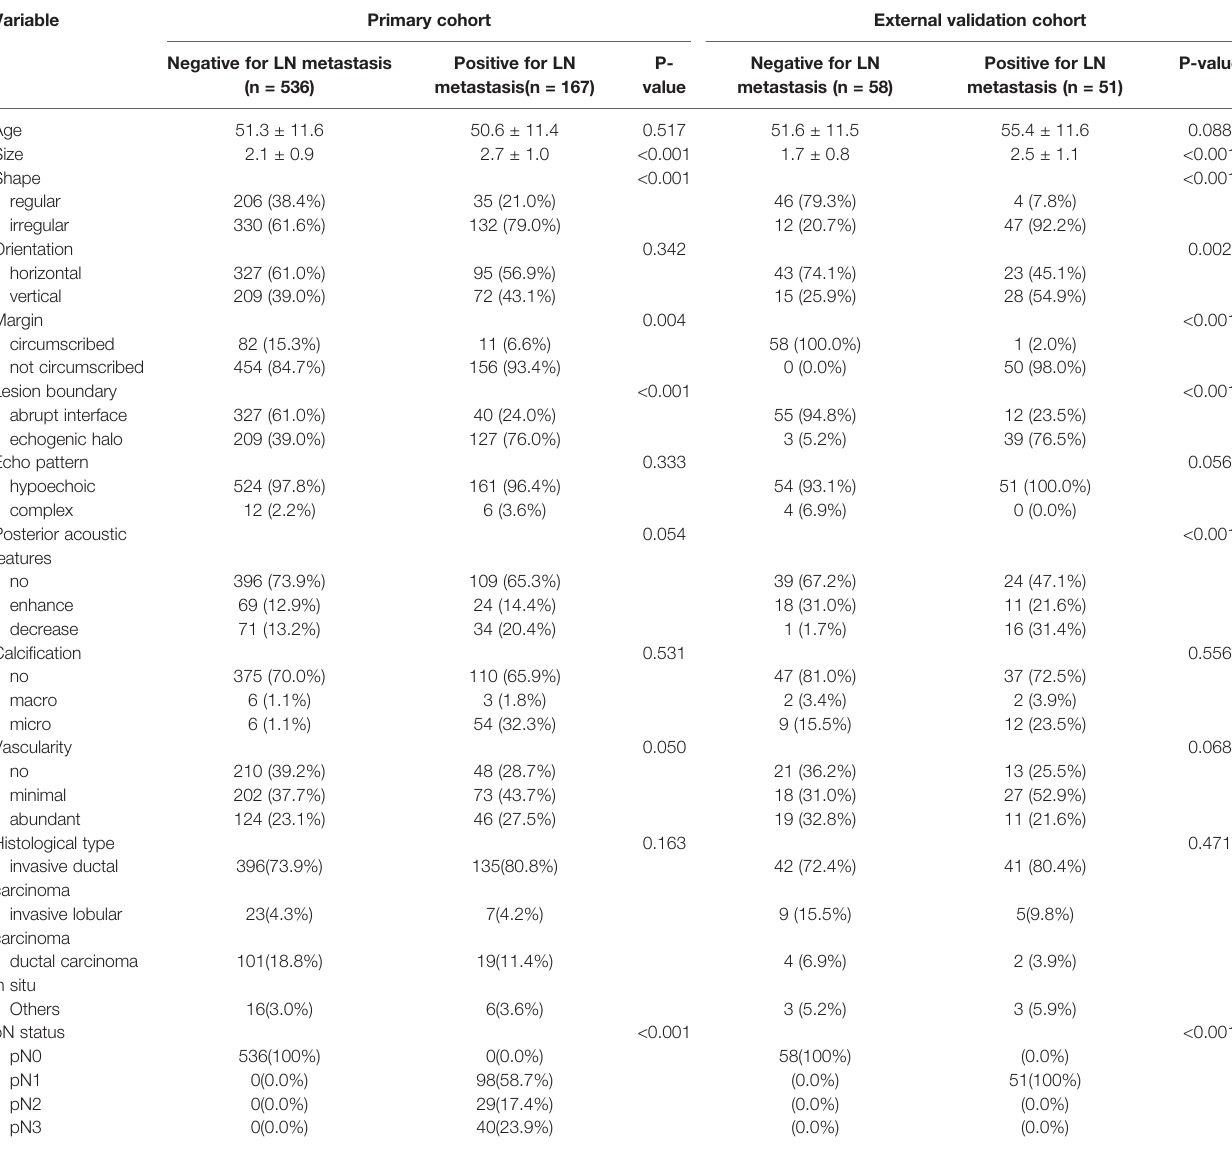
TABLE 2 | Baseline characteristics in the primary and external validation